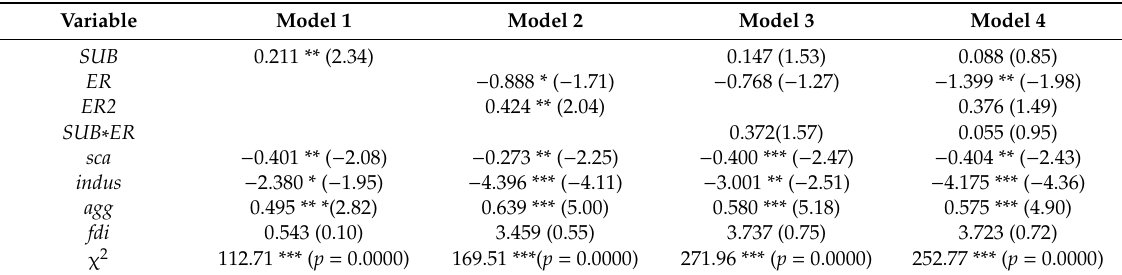
Table 3. Estimation results of e ff ects of government R&D subsidies and environmental regulations on